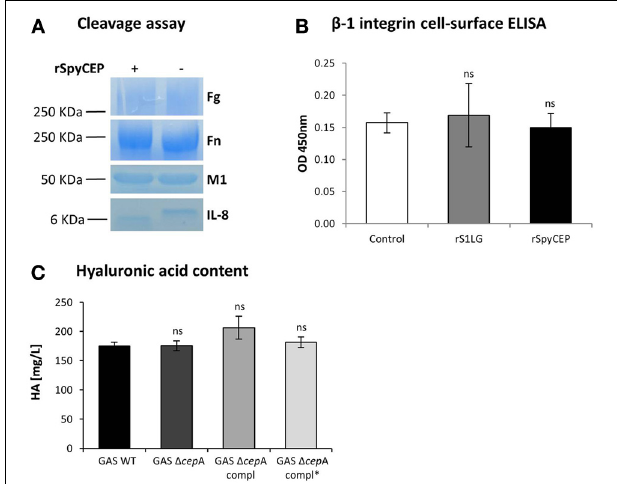
FIGURE 4 | Assessment of SpyCEP cleavage and hyaluronic acid content. (A) SpyCEP-mediated cleavage of proteins involved in bacteria-host cells interactions was assessed. After overnight incubation in the presence of recombinant SpyCEP (rSpyCEP, 100ng/ml), the samples were loaded on a polyacrylamide gel and cleavage assessed by coomassie blue staining. IL-8 was used as a positive control for the cleavage reaction. (B) β -1 integrin expression on EA.hy926 cells surface after exposure to buffer only (control), rSpyCEP (10 μ g/ml) or an unrelated protein (S1LG, 10 μ g/ml) purified using the same method. The graph represents two pooled experiments and error bars represent the standard deviation. (C) Hyaluronic acid (HA) content quantification in the GAS strains. Error bars represent the standard deviation, statistical analysis was carried out using a two-tailed t -test (ns = p > 0 . 05). The p -values are relative to GAS